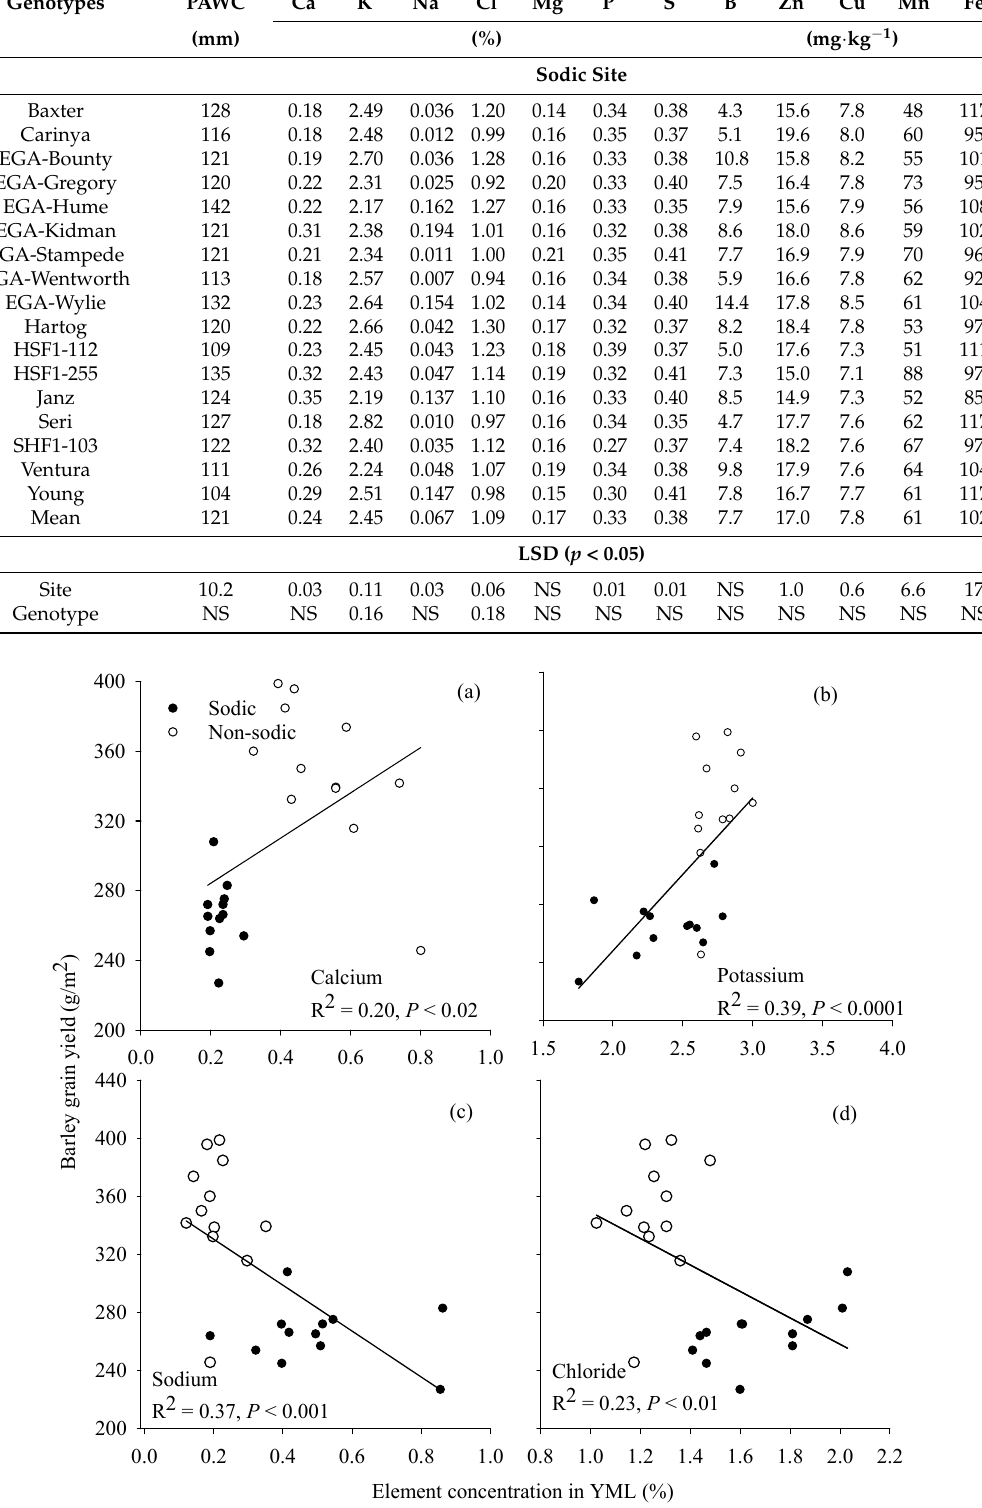
Figure 6. Relationships between grain yield of barley genotypes with element concentrations of ( a ) calcium, ( b ) potassium, ( c ) sodium, and ( d ) chloride in young mature leaves of wheat genotypes grown on a sodic site and a non-sodic site at Goondiwindi in southern Queensland in 2008.